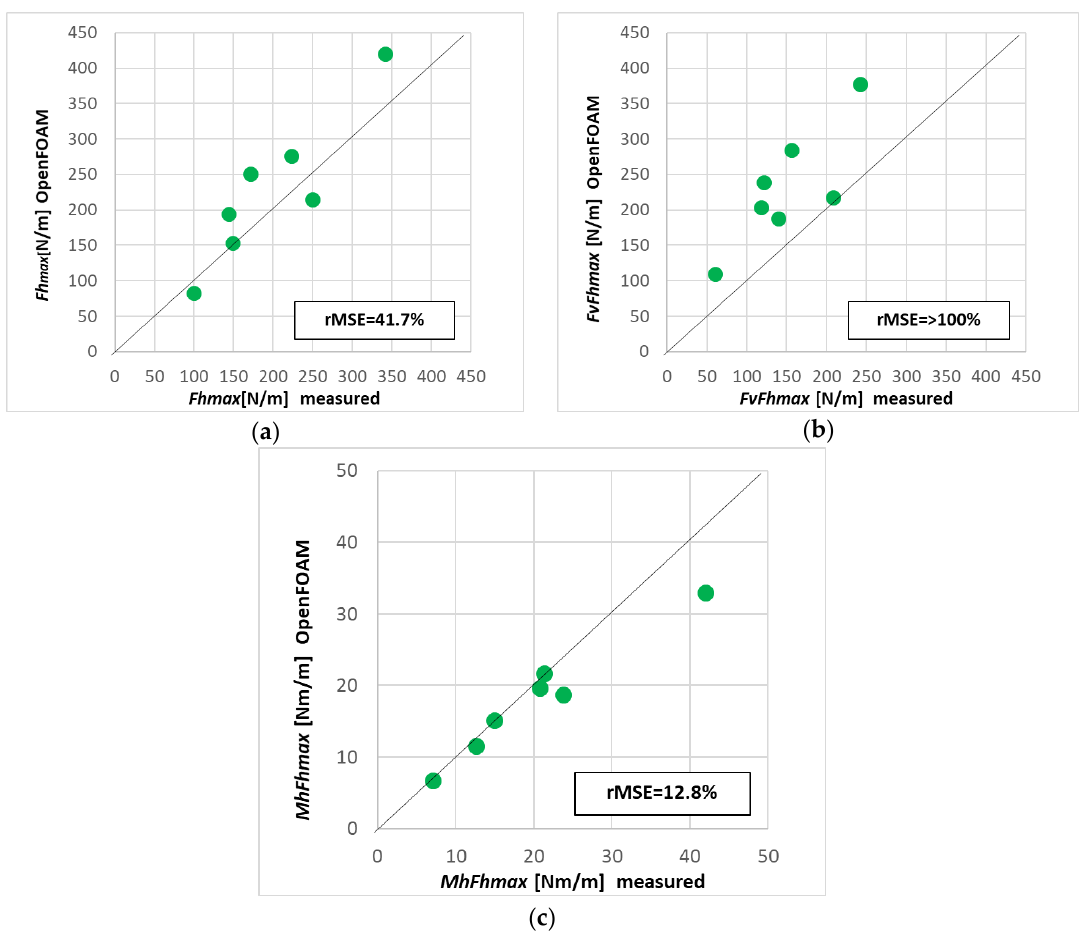
® : ( a ) Fh max , ( b ) FvFh max , and ( c ) MhFh max